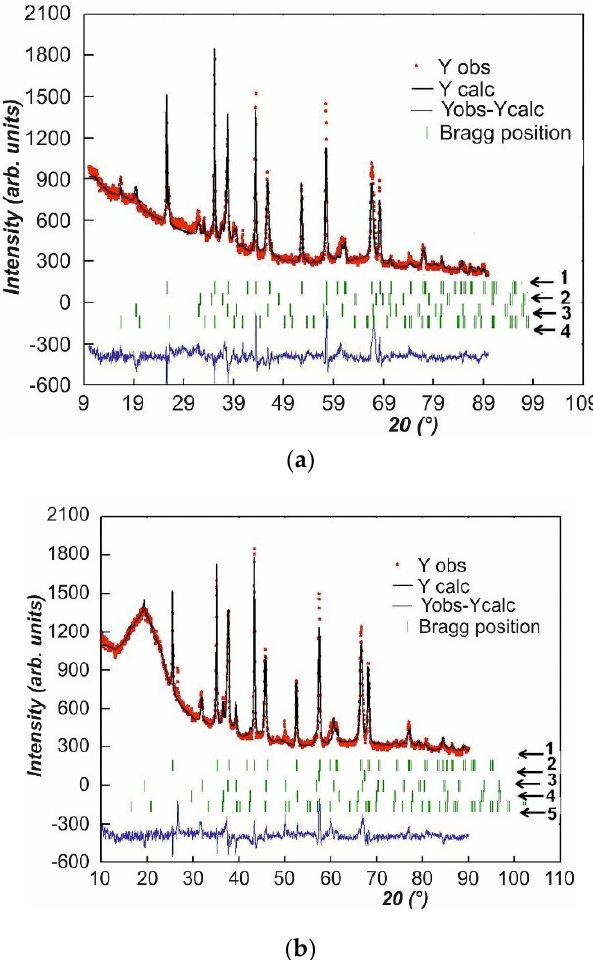
Figure 2. X-ray diffraction patterns of the PEO layers synthesized on AMg-6 ( a ) and D 16T ( b ) alloys. The designations of revealed phases: ( a ) 1— α -Al 2 O 3 , 2—Mg. 3— γ -Al 2 O 3 , 4—MgAl 2 Si 3 O 10 ; ( b ) 1— α -Al 2 O 3 , 2—Cu, 3— γ -Al 2 O 3 , 4—Cu 2 O, 5—SiO 2 Table 2. Phase composition of the PEO layers synthesized on AMg-6 and D16T alloys.